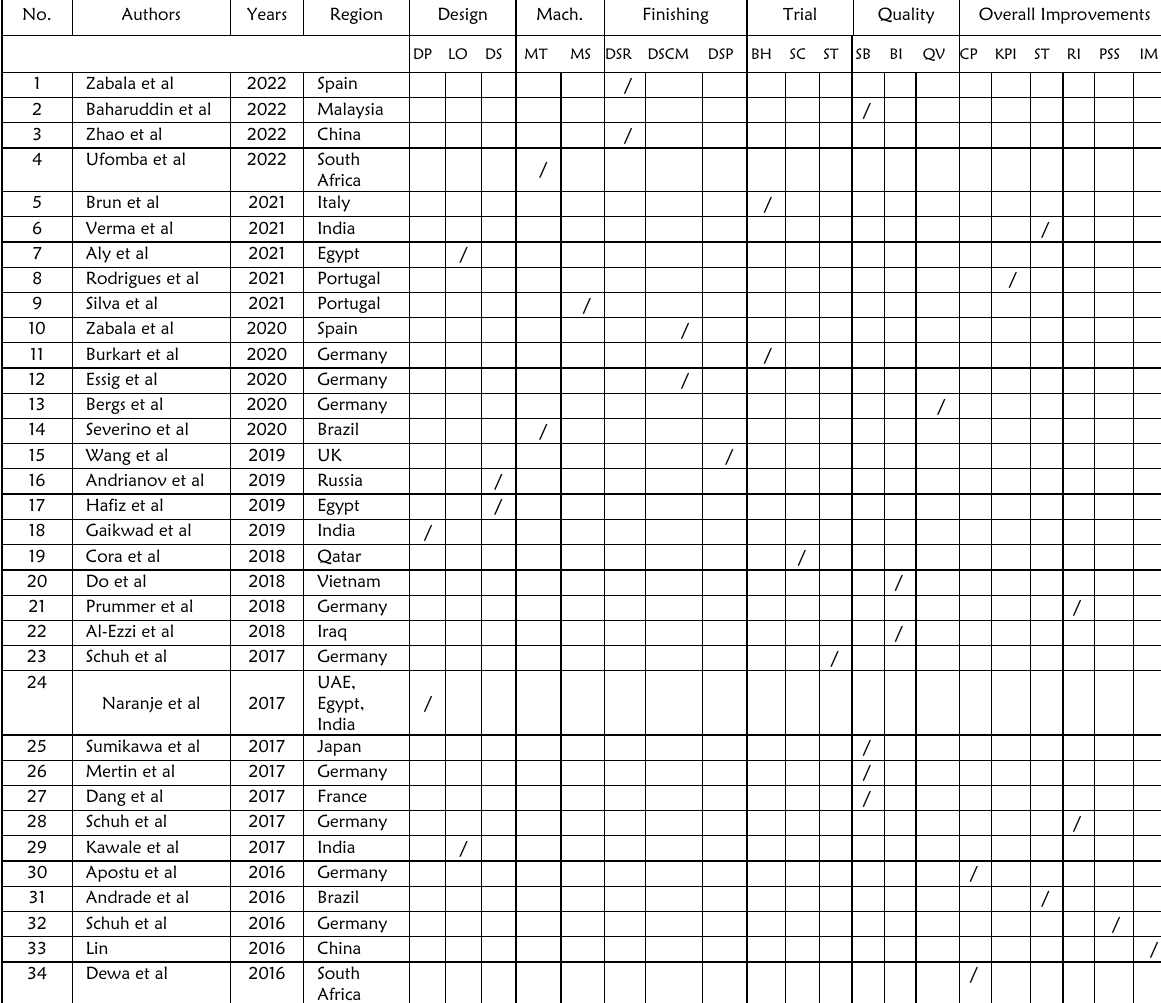
Table 12: The theme and sub-theme Design